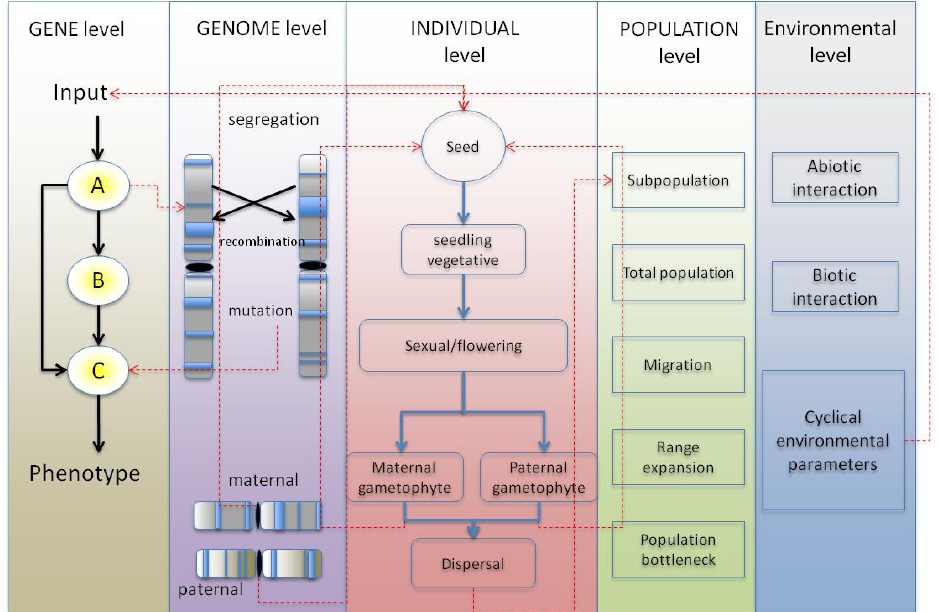
Figure 1. The levels of regulation within the proposed modeling framework. The five levels are: the genic level, genome, individual, population and environment. At the genic level, the genes interact with each other as a gene-regulatory networks (GRN) to produce a phenotype. At the genome level, these genes are arranged into chromosomes, which segregate at meiosis, and the comprising genes mutate and recombine, altering their function. The individual has various life cycle histories and if sufficiently fit from its comprising genetic material, reproduces with other individuals to produce progeny. The individuals make up the populations, which through admix through migration, and can lead to differentiation through bottlenecks and founder effects. The environment contains parameters that change cyclically (or unexpectedly), which is fed into the GRN of the